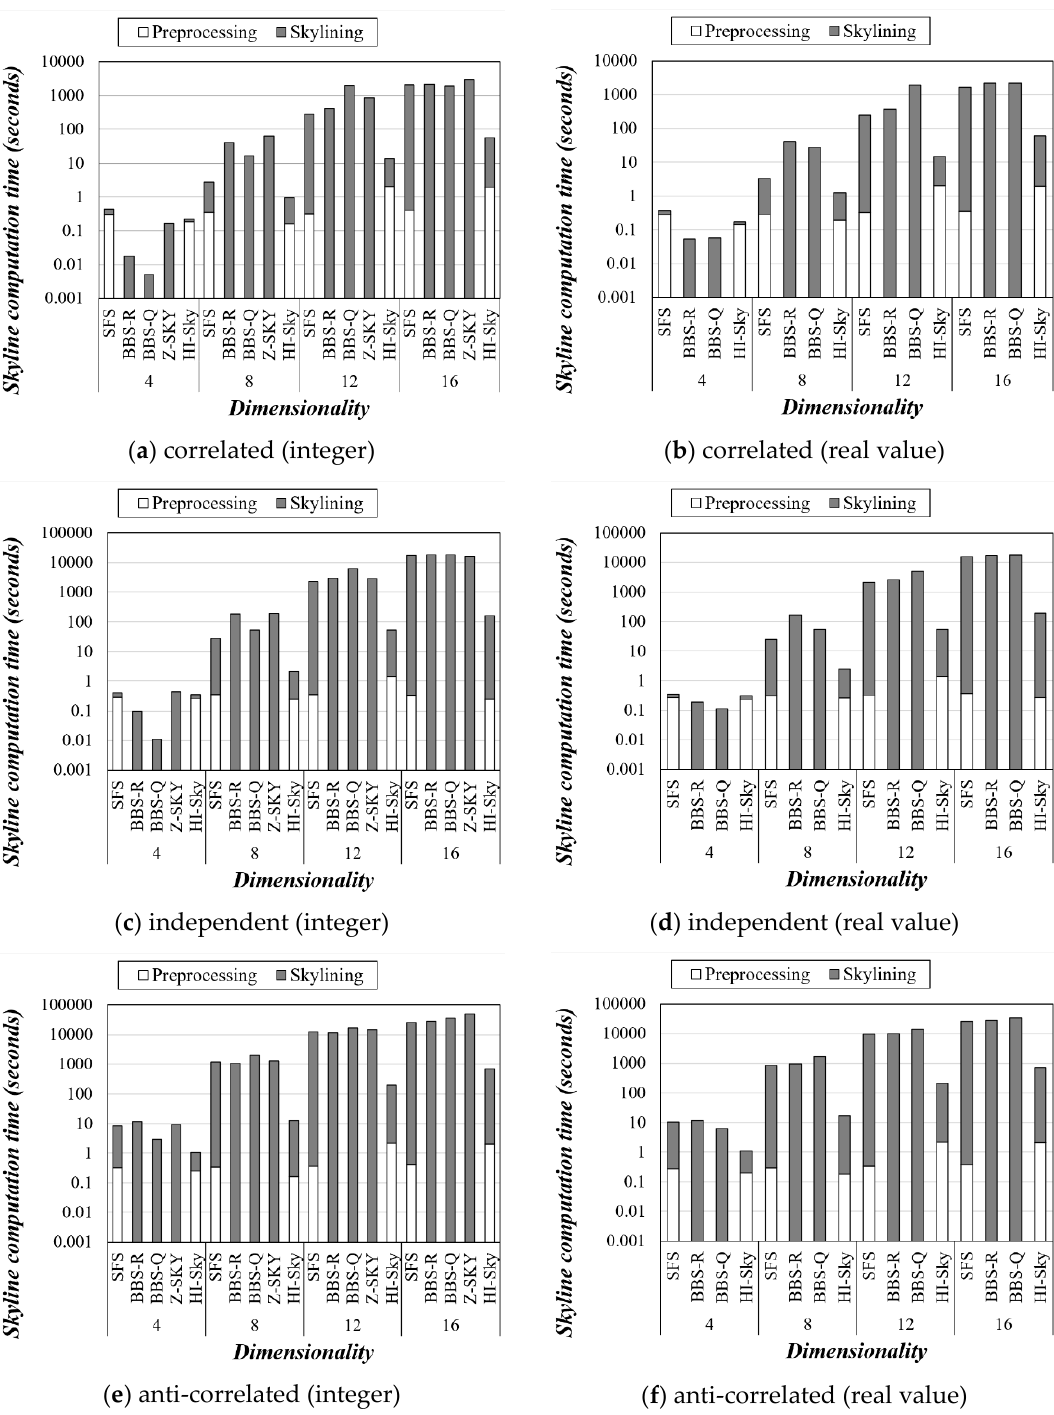
Figure 8. Skyline computation time according to dimensionality (1 Million).